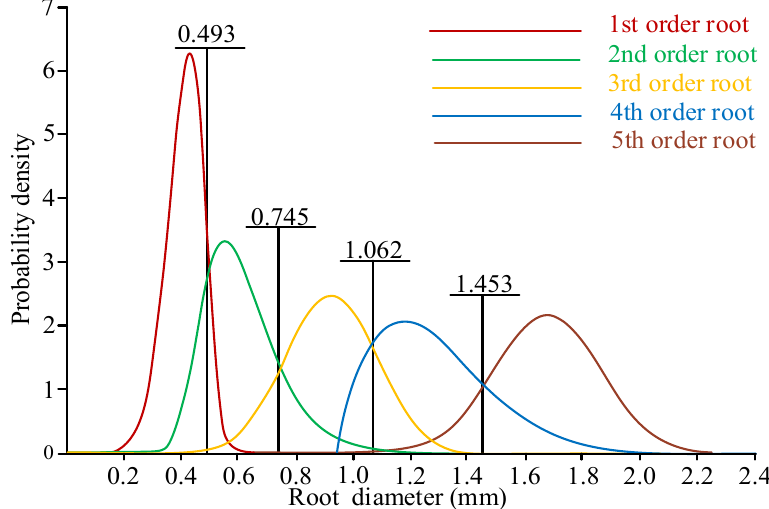
Figure 15. Result for method of five root orders [46].